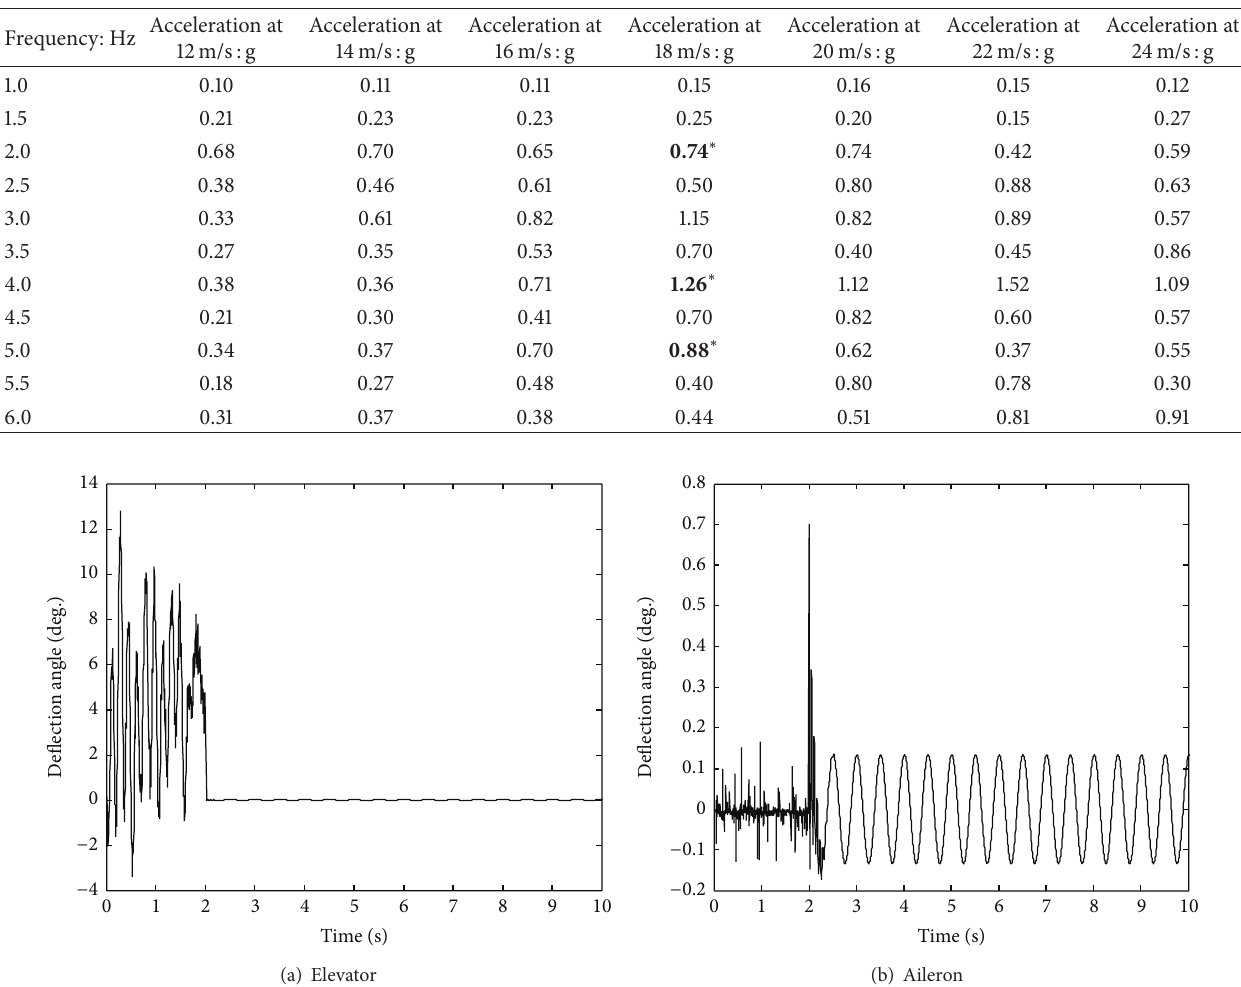
Table 3: Gust response alleviation result at fixed flow velocity and gust frequency.